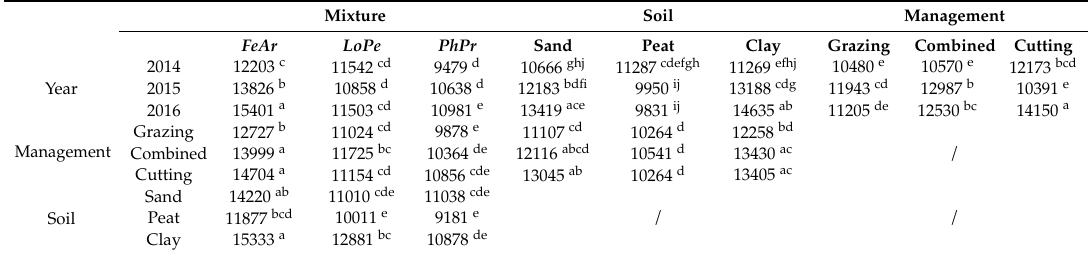
Table 4. Dry matter yields (Lsmeans, in kg DM ha − 1 ): all two-way interactions between mixture, management, year and site *.